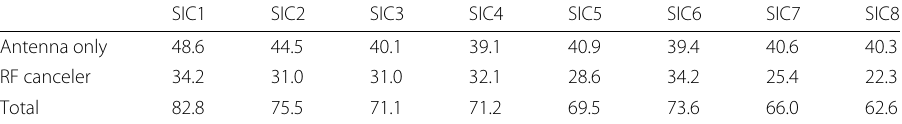
Table 2 Isolation provided by the original antenna and the RF canceler and the total isolation in dB SIC1 SIC2 SIC3